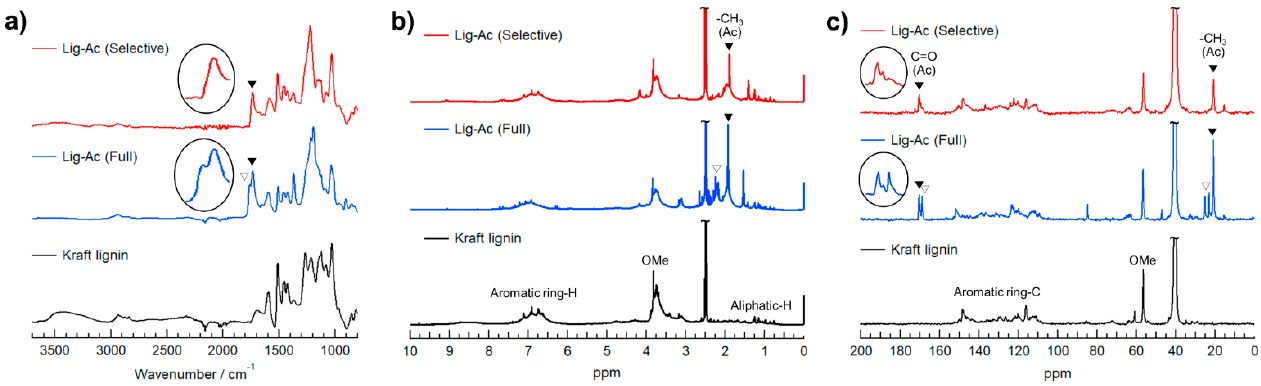
Figure 5. ( a ) ATR-mode FT-IR, ( b ) 1 H NMR, and ( c ) 13 C NMR spectra of Lig-Ac (Selective), Lig-Ac (Full), and Kraft lignin.